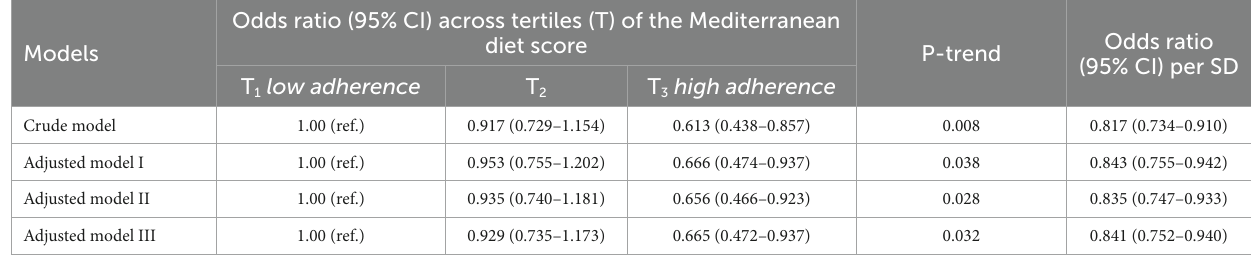
TABLE 4 Association between the Mediterranean diet scores and hepatic fibrosis (defined through the FIB-4 score) in patients with NAFLD.